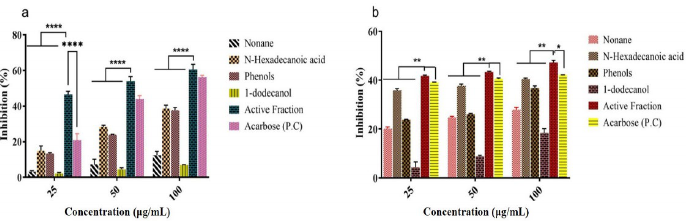
Figure 10. In vitro α -amylase and α -glucosidase inhibitory activity of pure compounds. ( a ) α -amylase and ( b ) α -glucosidase inhibition of isolated compounds and its active fraction (F4). Absorbance was measured at 540 nm and 405 nm. Values are means ± S.E.M ( n = 3). Mean values were analyzed using two-way ANOVA (Tukey’s multiple comparisons test). **** p < 0.0001, ** p < 0.01, * p < 0.05 were considered